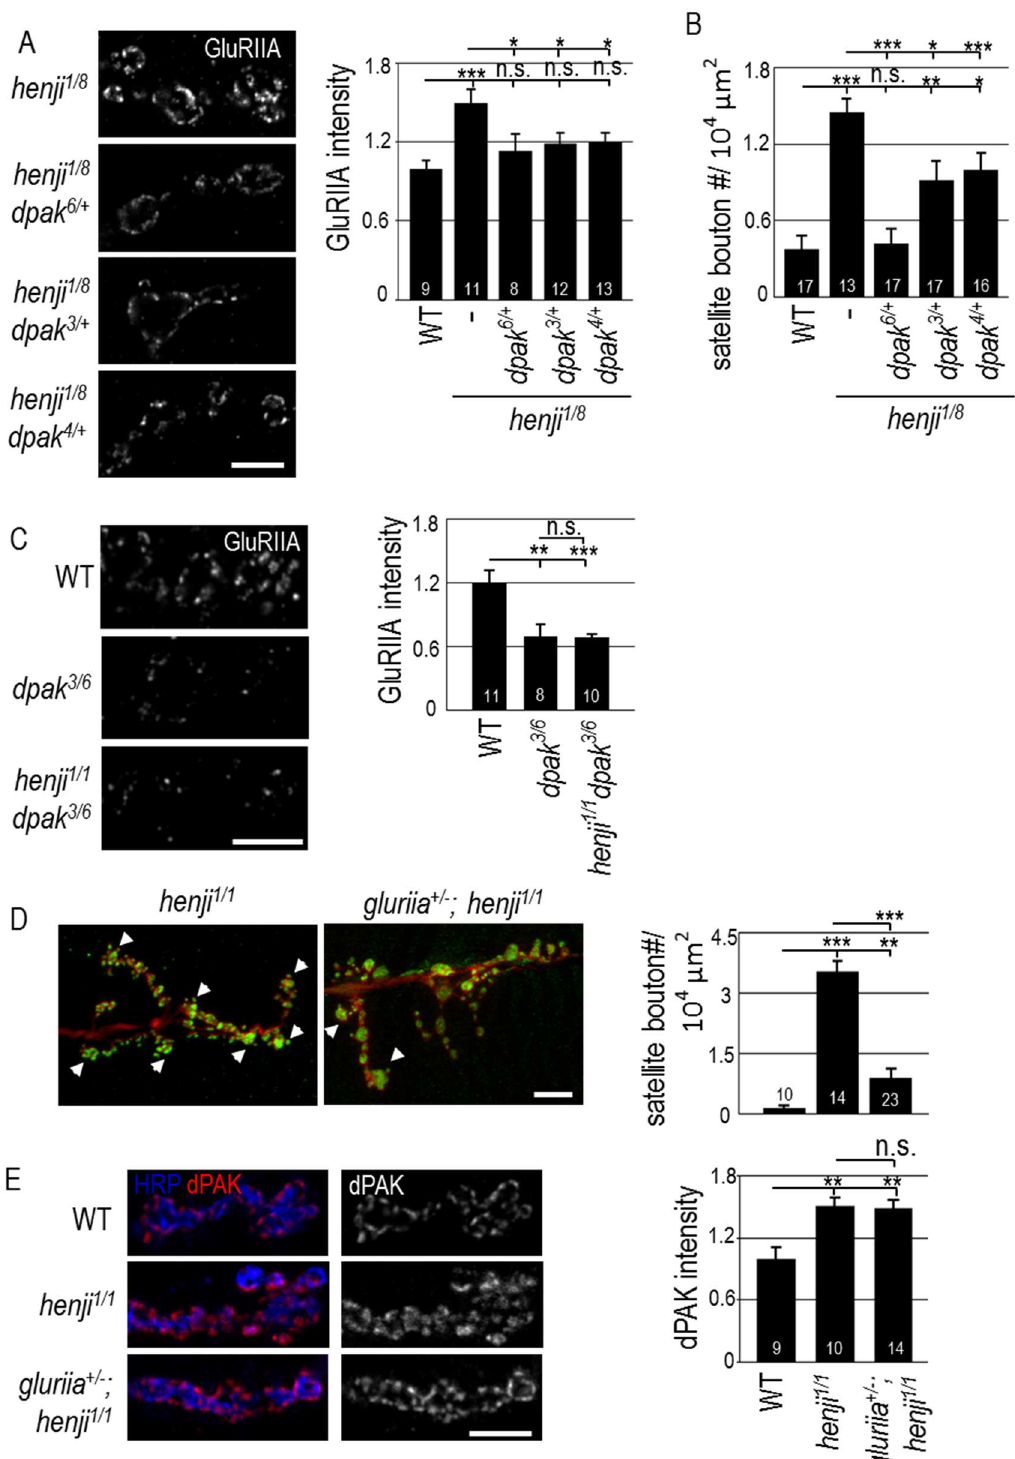
Fig 5. Decreased dpak or gluriia gene dosages suppress henji phenotypes. (A) Immunostaining for GluRIIA in henji 1/8 and henji 1/8 carrying dpak mutations. Scale bar is 5 μ m. Bar graph at right shows quantification of GluRIIA intensity normalizedto HRP in WT, 1.00 ± 0.06; henji 1/8 , 1.50 ± 0.11; dpak 6/+ henji 1/8 , 1.13 ± 0.13; dpak 3/+ henji 1/8 , 1.19 ± 0.08; and dpak 4/+ henji 1/8 , 1.20 ± 0.08. (B) Suppression of satellite boutons quantifiedin WT, 2.82 ±